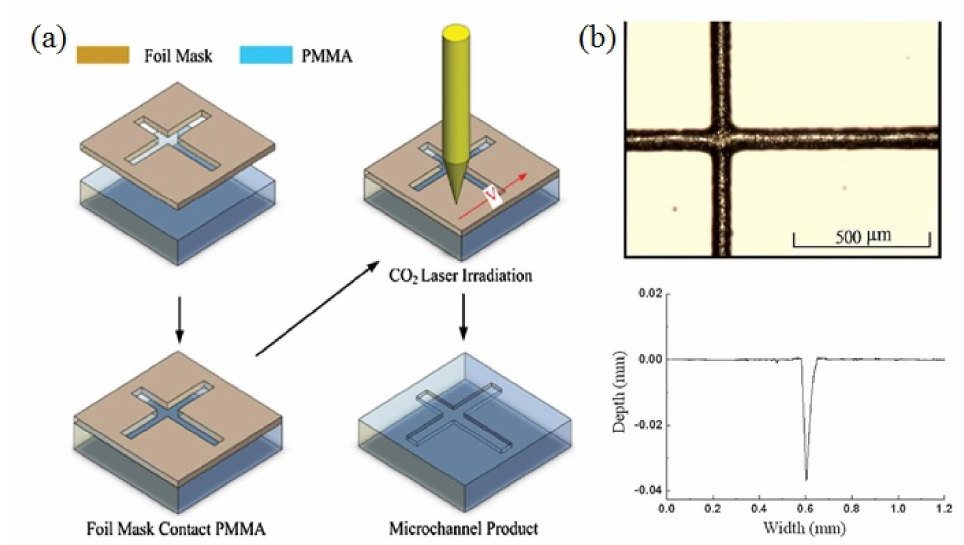
Figure 3. ( a ) Schematic process flow of the FACLAM technique including the metal foil mask on 2 mm PMMA and the scanning CO 2 laser source. ( b ) Optical micrograph and α -step profile of the PMMA cross-microchannel formed by one-pass ablation.